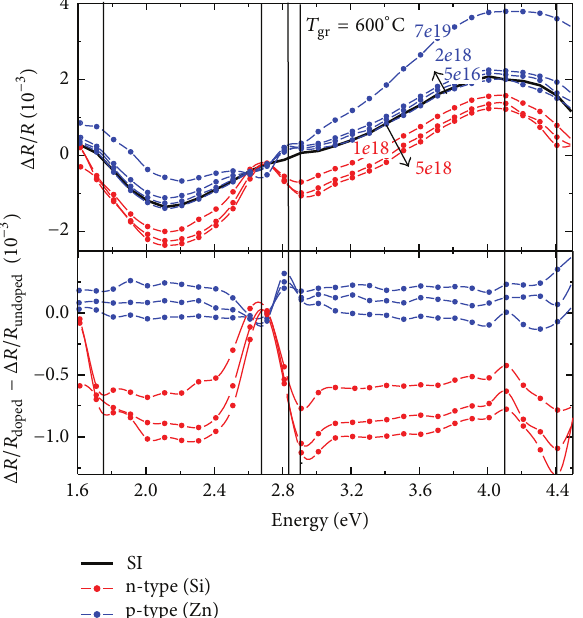
−Δ𝑅/𝑅 ) for p-type: Zn (blue) and n-type: Si (red) doped Ga 0.99 In 0.01 As doped undoped